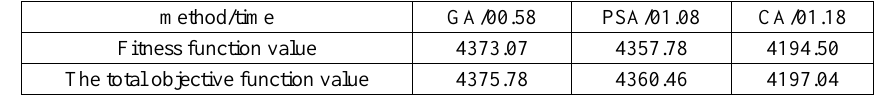
Table 4 . Algorithm